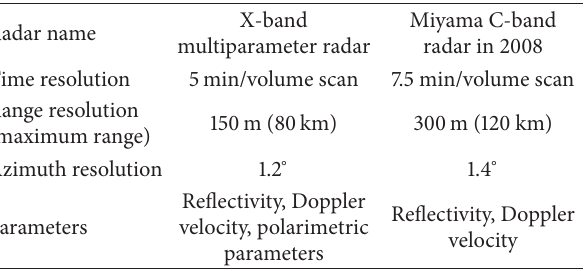
Table 1: List of specifications of the installed X-band radars and the Miyama C-band